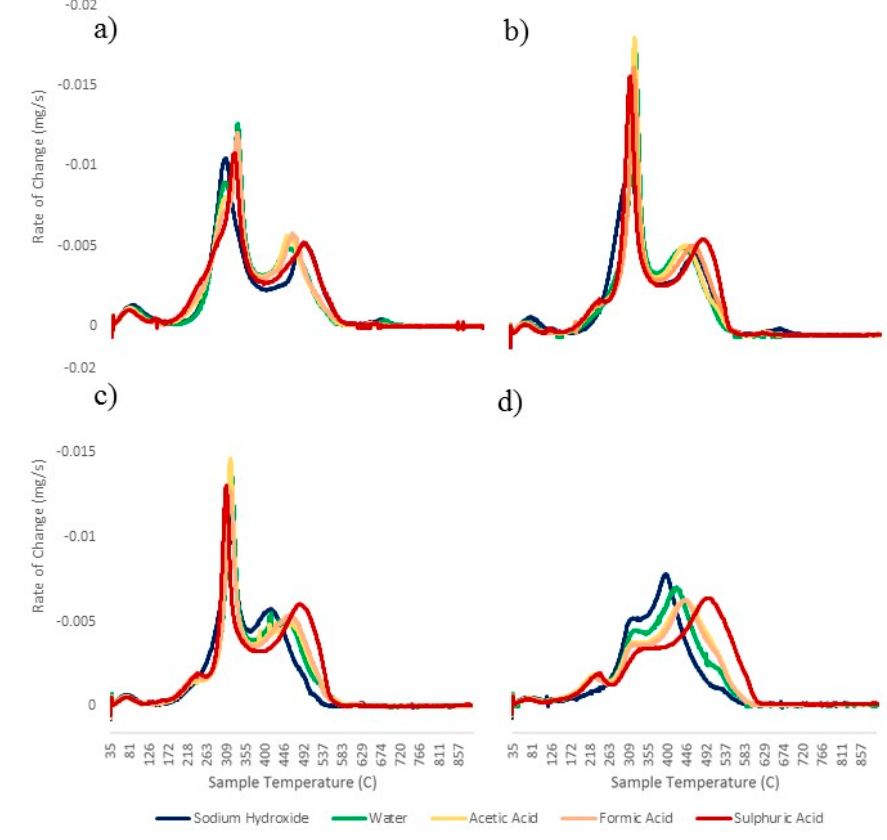
Figure 2. Derivative thermogravimetric (DTG) burning profiles for ( a ) 120 °C, ( b ) 170 °C, ( c ) 200 °C, and ( d ) 250 °C treatments .